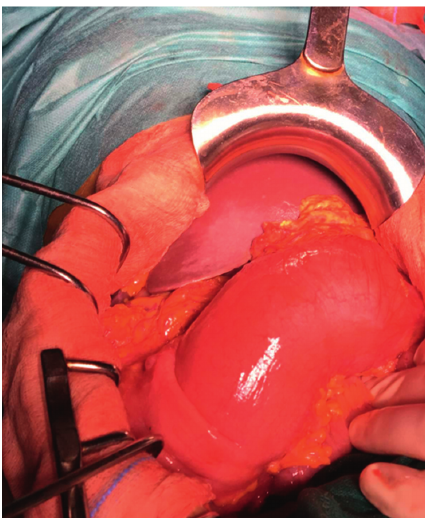
Figure 4: Operative image showing colocolic